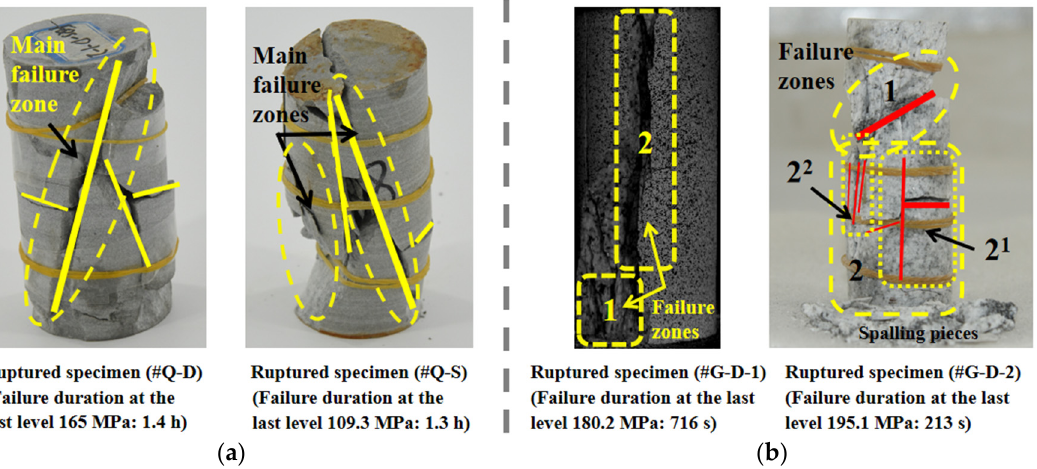
Figure 14. Failure specimens of quartz sandstone and granite. ( a ) Quartz sandstone. ( b ) Granite.